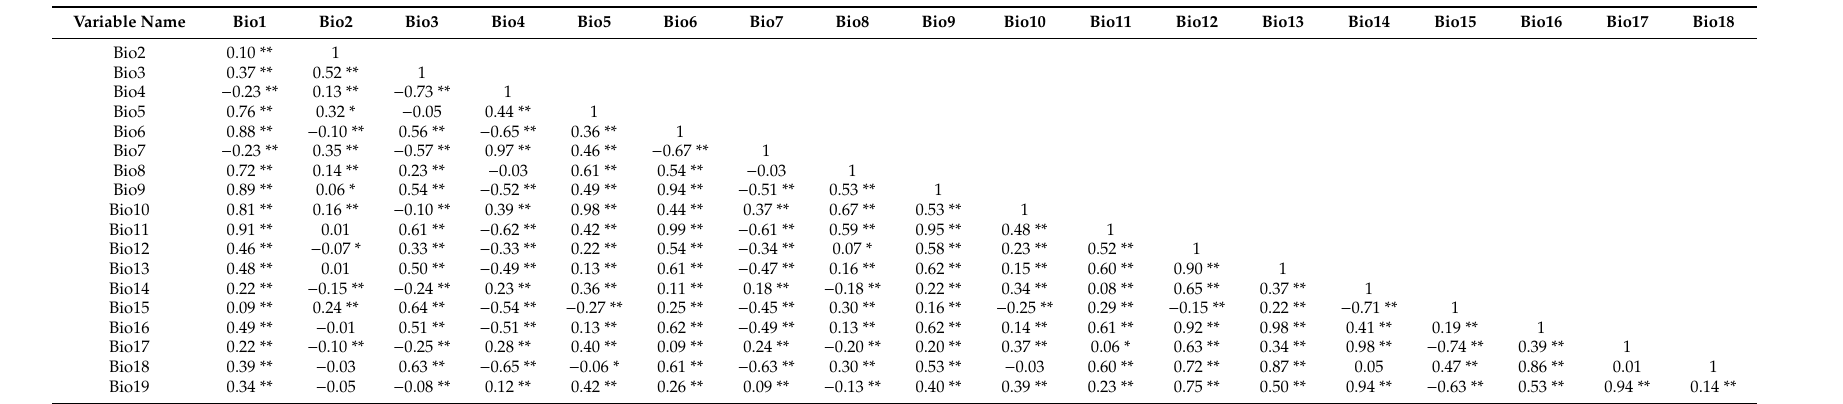
Table A2. The correlation coe ffi cients between the climate